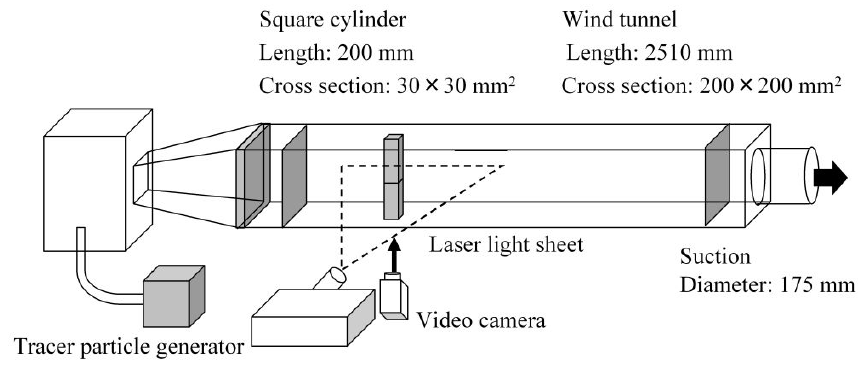
Fig.1 Experimental setup.